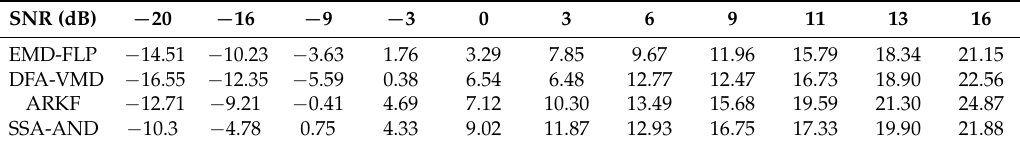
Table 2. Comparison of the singular spectrum analysis-augmented nonlinear differentiator (SSA-AND) to other de-noising methods with different signal-to-noise power ratios (SNRs). EMD-FLP: empirical mode decomposition-forward linear prediction; DFA-VMD: detrended fluctuation analysis-variational mode decomposition; ARKF: adaptive robust Kalman